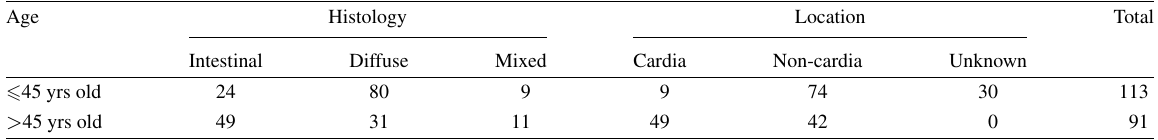
Clinicopathological